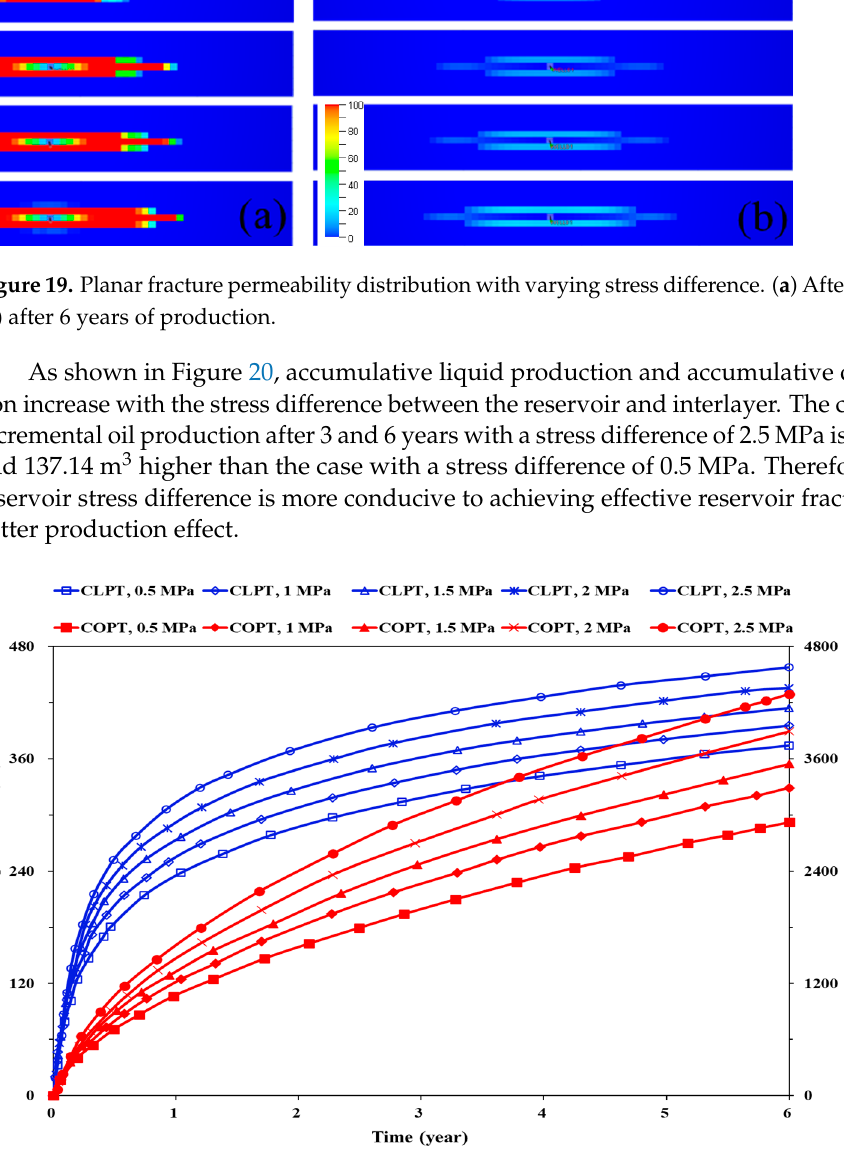
Figure 21. Production performance curves for different Young’s modulus values.